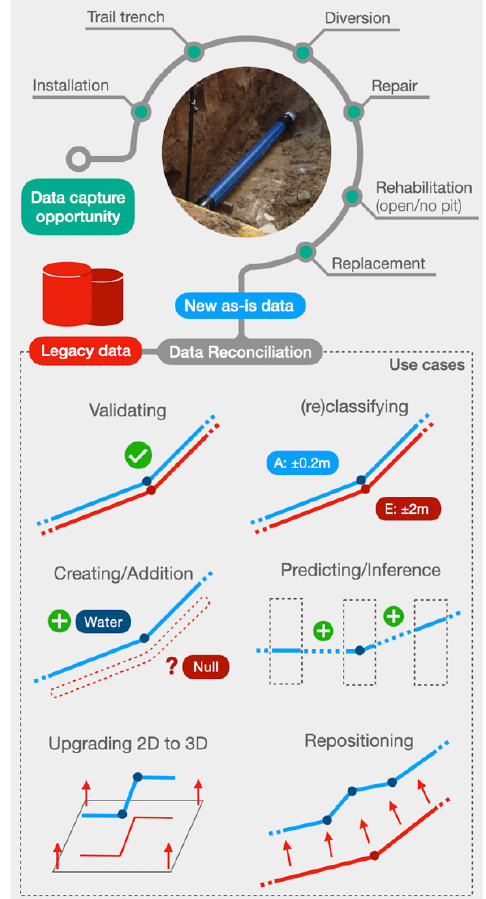
Figure 2. Data collection opportunities and data reconciliation use